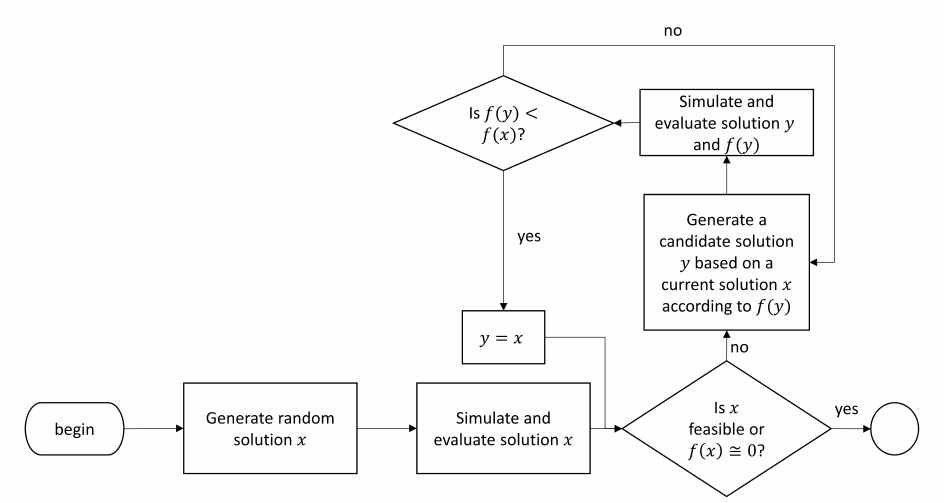
Figure 6. Flow diagram of the initial solution generation